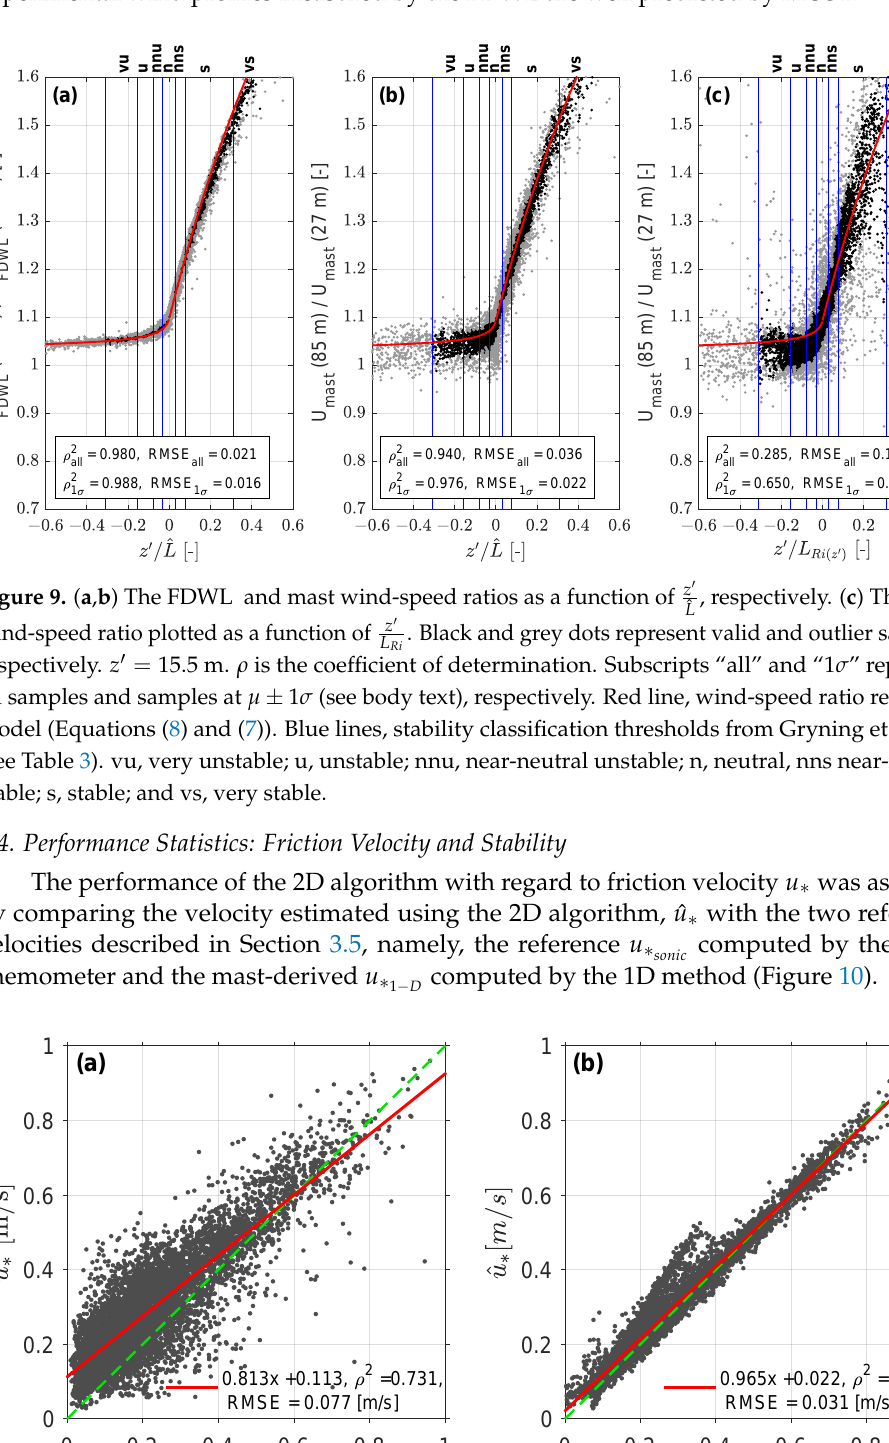
in Section 3.5: ( a ) sonic anemometer reference velocity u ∗ velocity u ∗ 1 − D . Green line is the reference 1:1